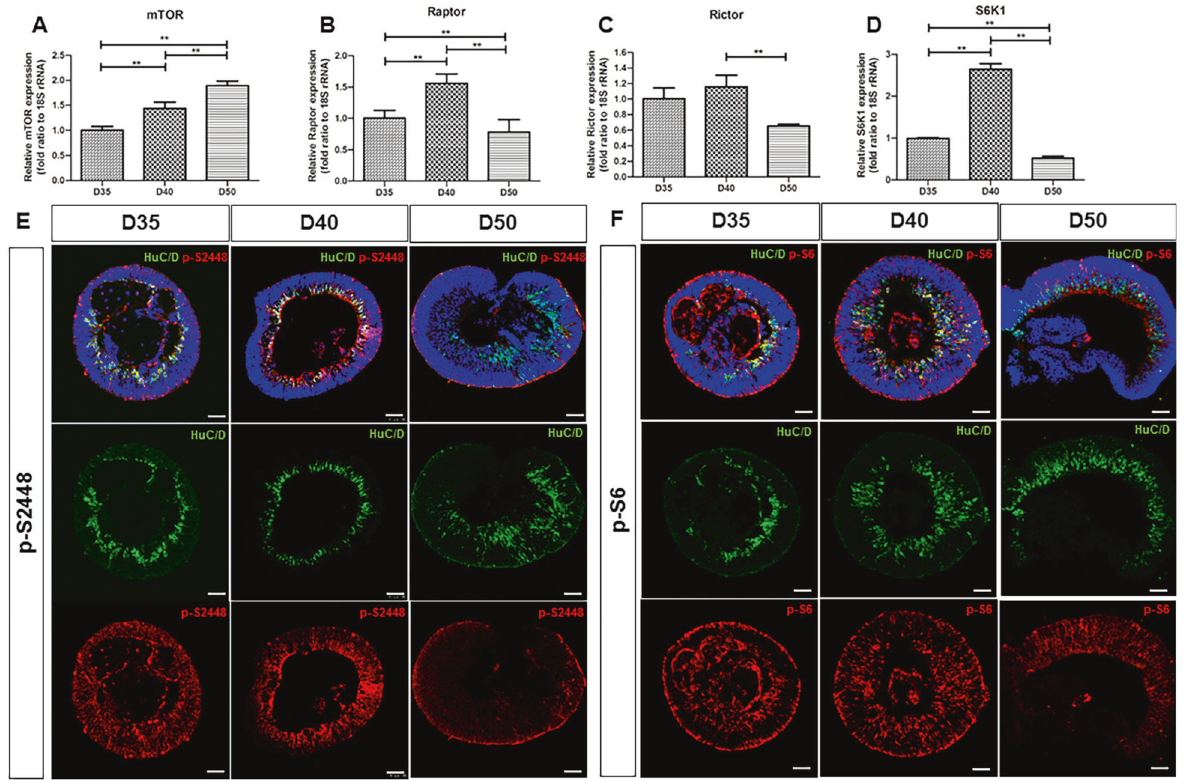
Fig. 2 mTOR activity during early stages of RO development. Quantitative RT-PCR of A total mTOR, B Raptor, C Rictor, and D S6K1 using ROs at indicated days of development. Immuno fl uorescence staining of HuC/D (green) and p-S2448 (red) ( E ) or p-S6 (red) ( F ) of RO at indicated time points. After 35 days of differentiation, both p-S2448 and p-S6 expressions in ROs showed upregulation mainly in the inner layers which co-localized with HuC/D expression, while more robust expressions were found in the outer layers as well as the inner layers of ROs after 40 days of differentiation. Limited p-S2448 and p-S6 activities in outer layers of ROs with scarce co-localization with HuC/D + cells were noted after 50 days of differentiation. ** p < 0.01, by the Kruskal – Wallis test with post hoc analysis. Scale bar, 50 μ